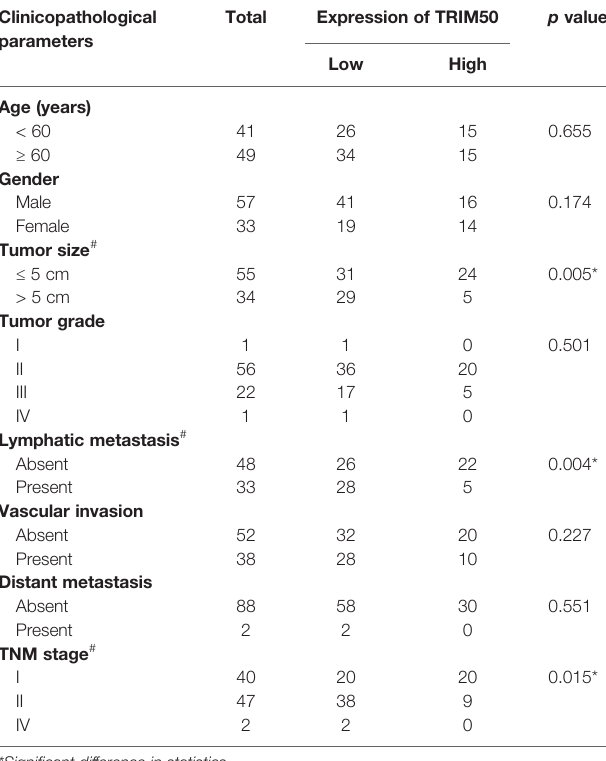
TABLE 1 | Correlations between TRIM50 expression and clinicopathologic parameters in pancreatic cancer patients. Clinicopathological